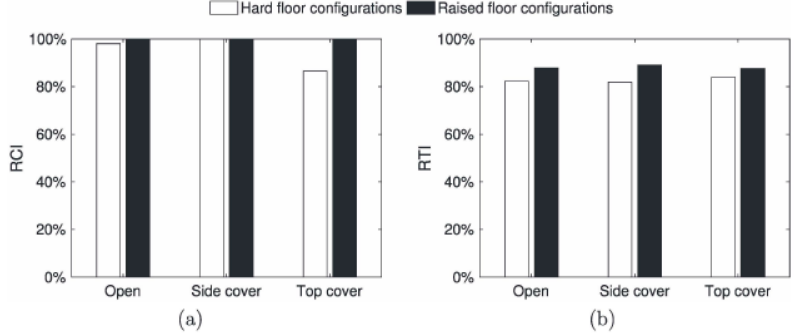
Figure 12. ( a ) RCI and ( b ) RTI for all setups with 50% supply flow rate.